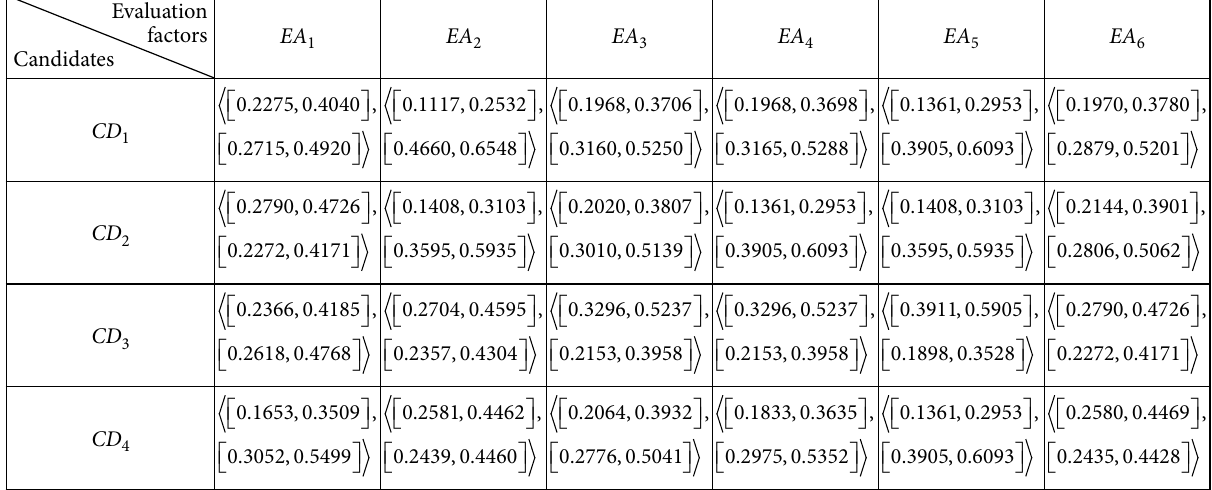
Table 6. Aggregated IVIF